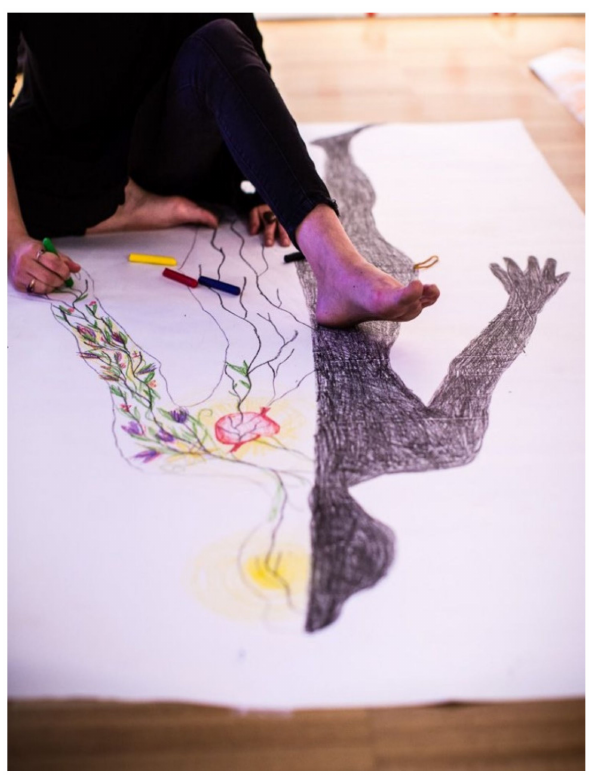
Figure 1. An example of a body map being created. This map was made during a workshop on body mapping anxiety facilitated by team members in Sydney in 2017. Photograph by Diane